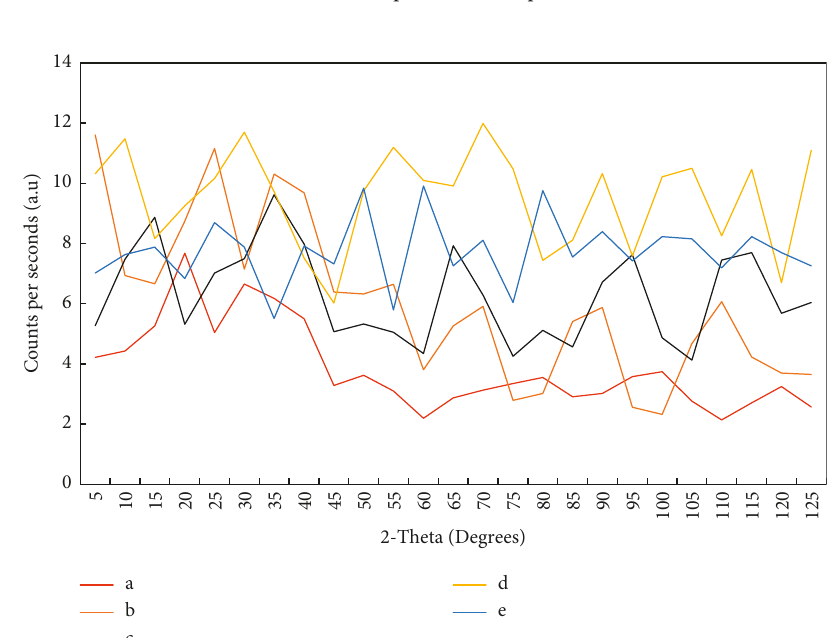
Figure 5: XRD pattern of the product.